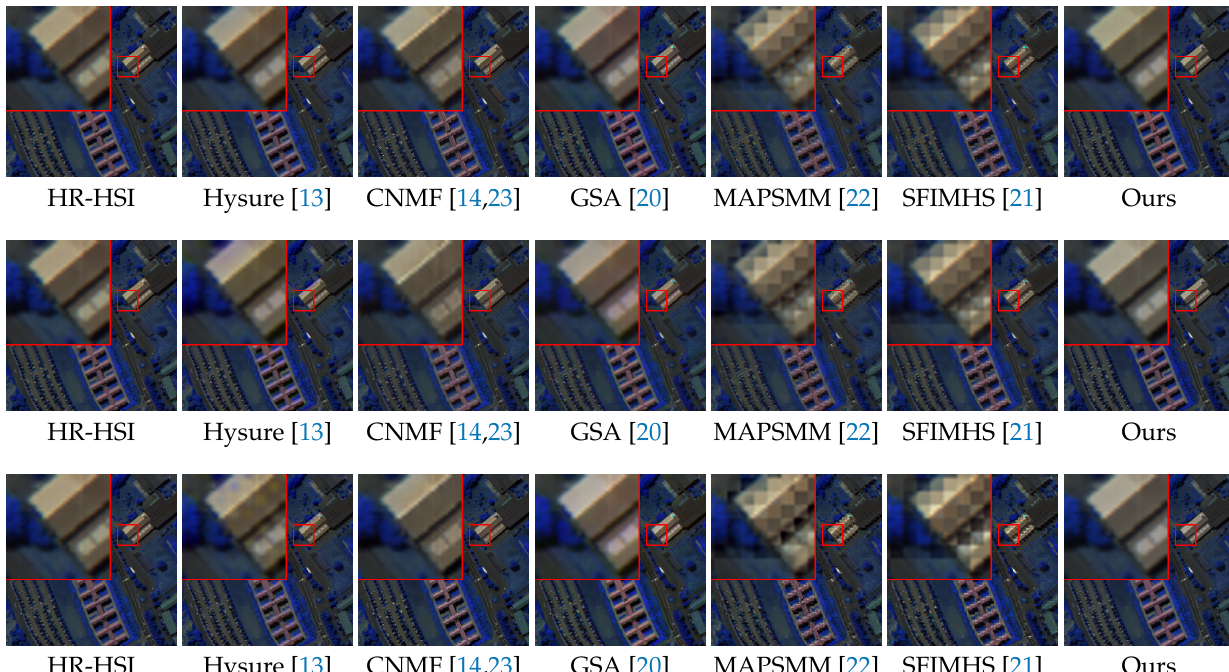
Figure 2. Fusion results on the Pavia University dataset (formed by bands 30th, 60th, and 90th). First row, SRF1,PSF1 case, fusion image of the comparison method; Second row, SRF2,PSF1 case, fusion image of the comparison method; Third row,